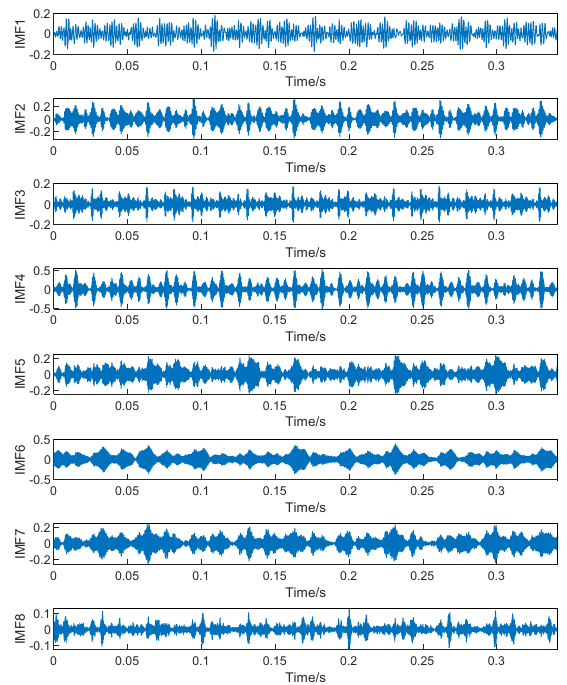
Figure 15. VMD decomposition result of fault signal. The value of the envelope spectral peak factor is calculated for each IMF component in the above figure, and the result obtained is shown in Figure 16.